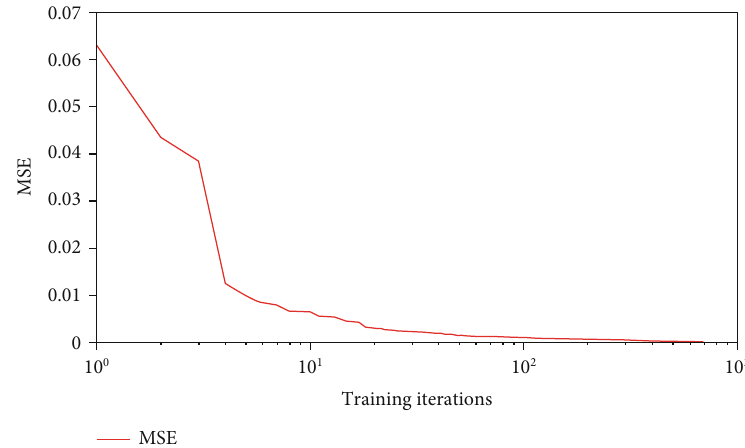
Figure 4: Training process of the neural network with the minimum MSE.